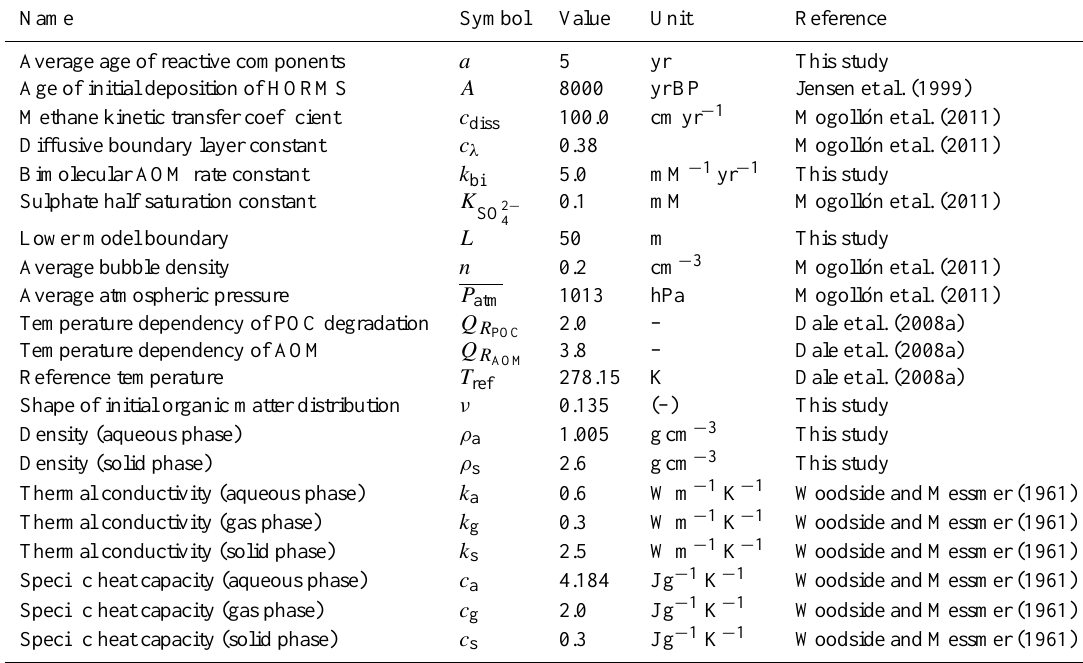
Table 2. Time-invariable parameters used in the model.